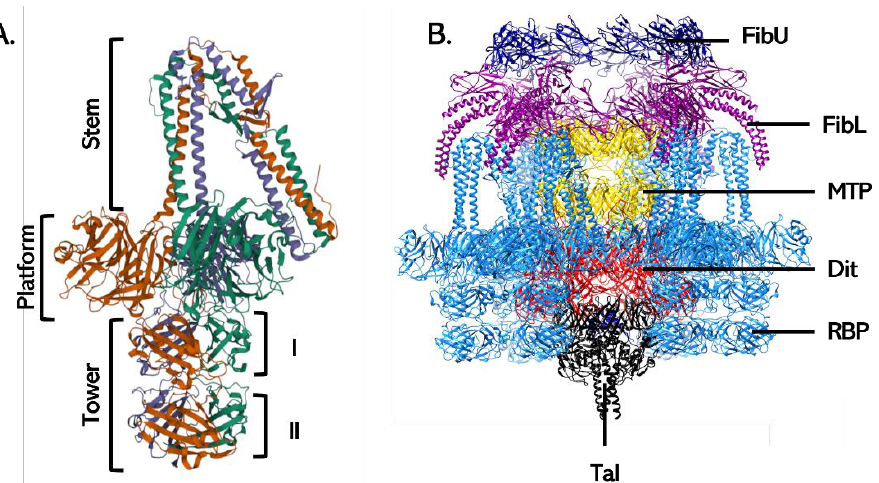
Figure 10. Tail proteins constituting the baseplate of S. aureus siphoviruses. ( A ) The RBP of φ 11 (gp45) has a modular organization with three domains. N-terminal stem domain, central platform with the receptor binding site, and C-terminal tower domain consisting of two similar regions. ( B ) Phage 80 α baseplate is particular in that it harbors, in addition to the RBP, two other tail fibers (FibL and FibU) that may be involved in adsorption. The Tal and FibU could not be completely modeled, and only the N-terminal part of the FibL are shown for clarity purposes. FibU: Upper tail fiber (dark blue); FibL: Lower tail fiber (purple); RBP: Receptor Binding Protein (blue); Tal: Tail lysin (black). MTP: Major Tail Protein (Yellow). Structures were retrieved from the Protein Data Bank ( φ 11 RBP: PDB 5EFV and [129]; 80 α baseplate: 6V8I and